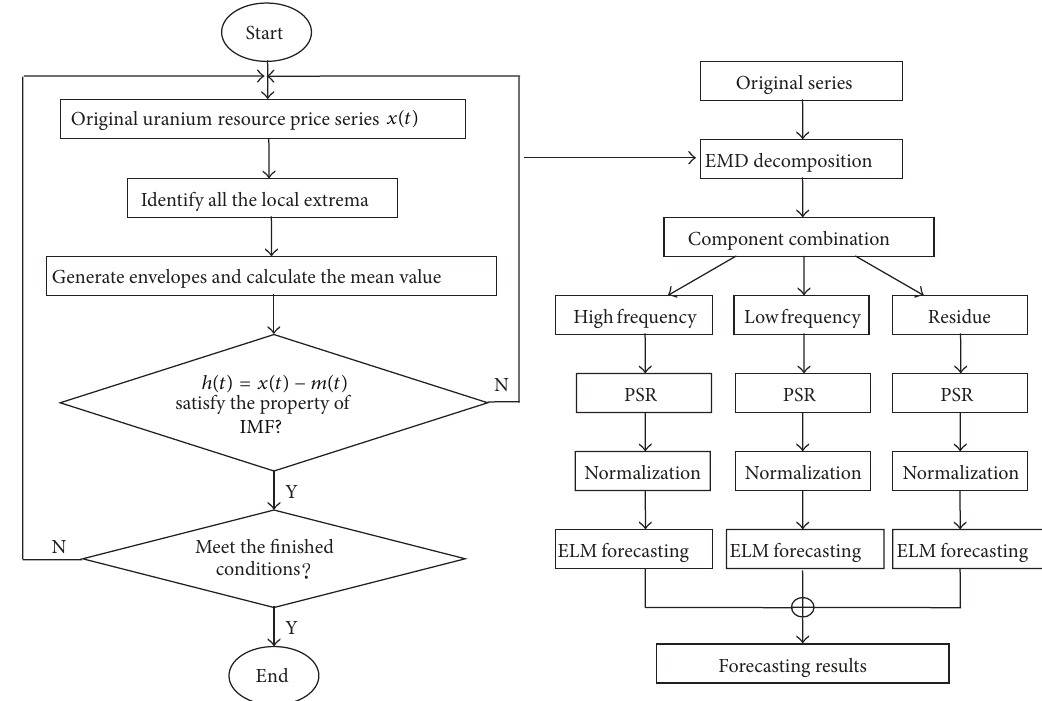
Figure 1: Schematic representation of the proposed EMD-PSR-ELM method.